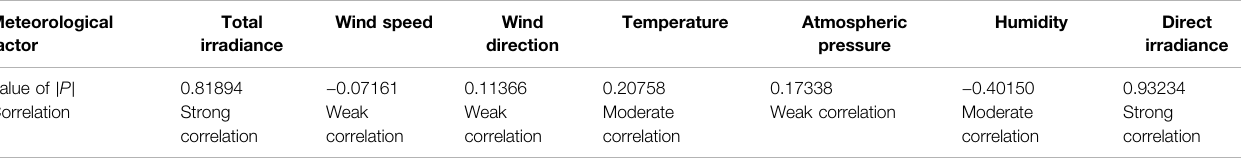
TABLE 1 | The Pearson correlation coef fi cients between PV outputs and meteorological